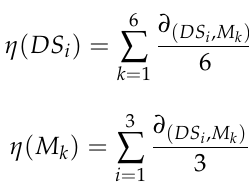
Figure 17. Average ROC between three datasets.